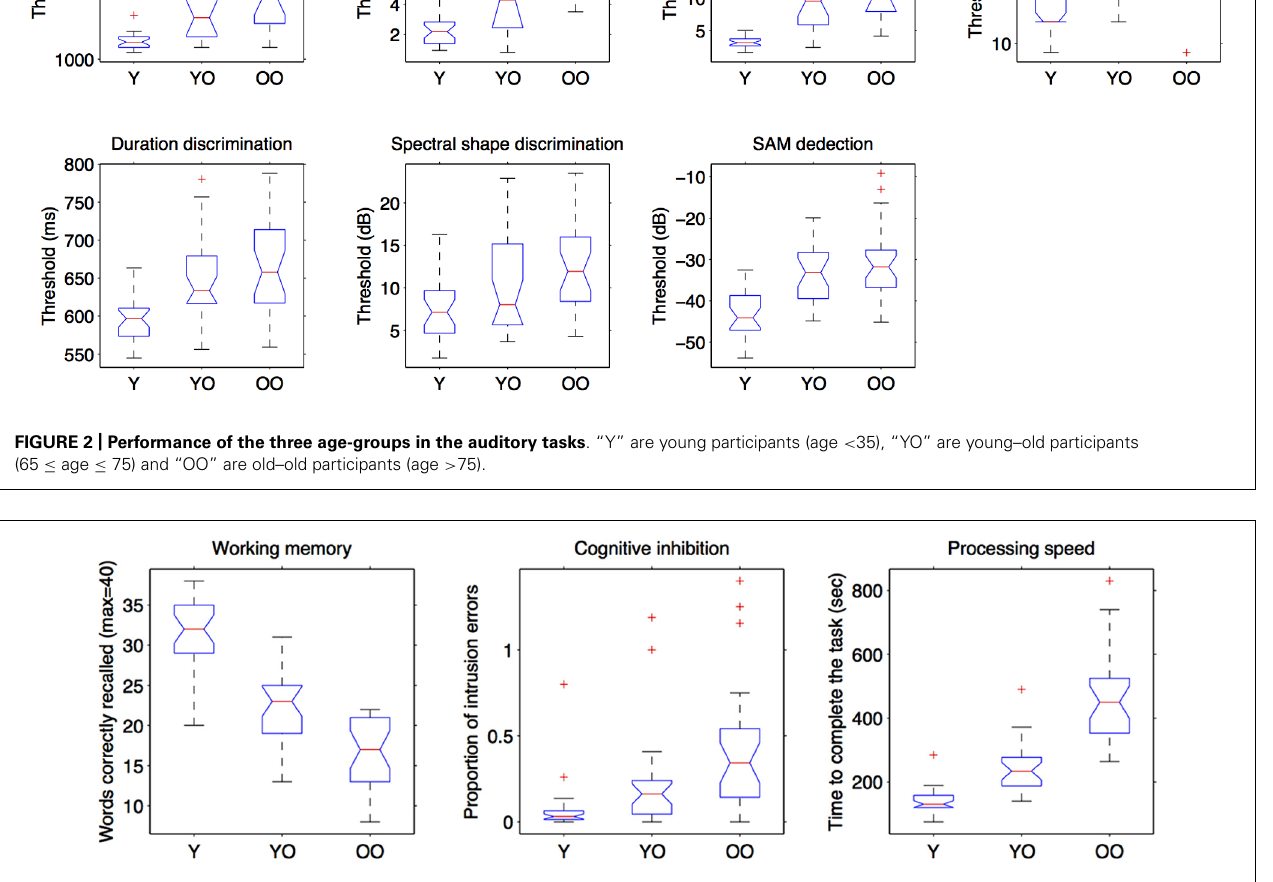
FIGURE 3 | Performance of the three age-groups in working memory, cognitive inhibition, and processing speed tasks . “Y” are young participants (age < 35), “YO” are young–old participants (65 ≤ age ≤ 75) and “OO” are old–old participants (age >